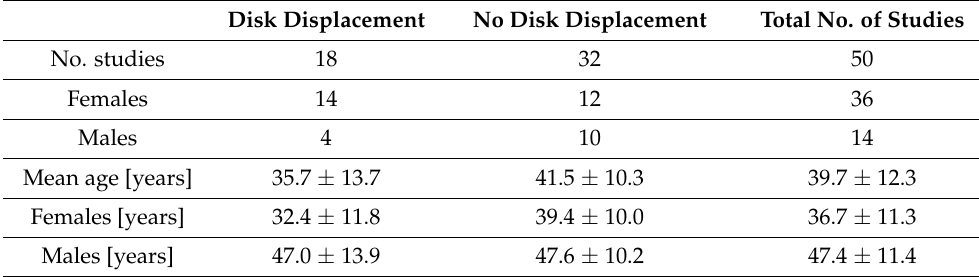
Table 1. Characteristics of the included